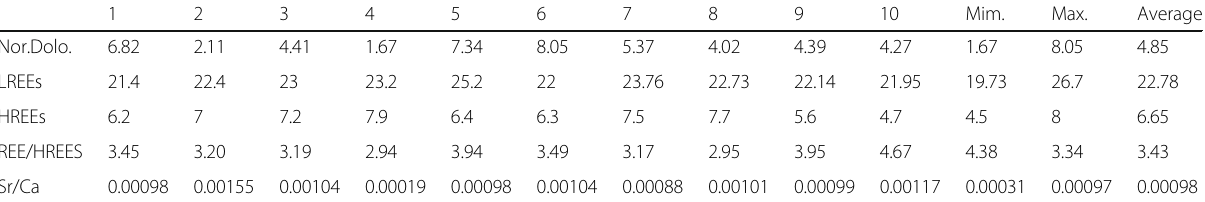
Table 1 Chemical analysis data of major oxides (%) and trace rare earth elements (ppm), of the studied rocks (Continued)